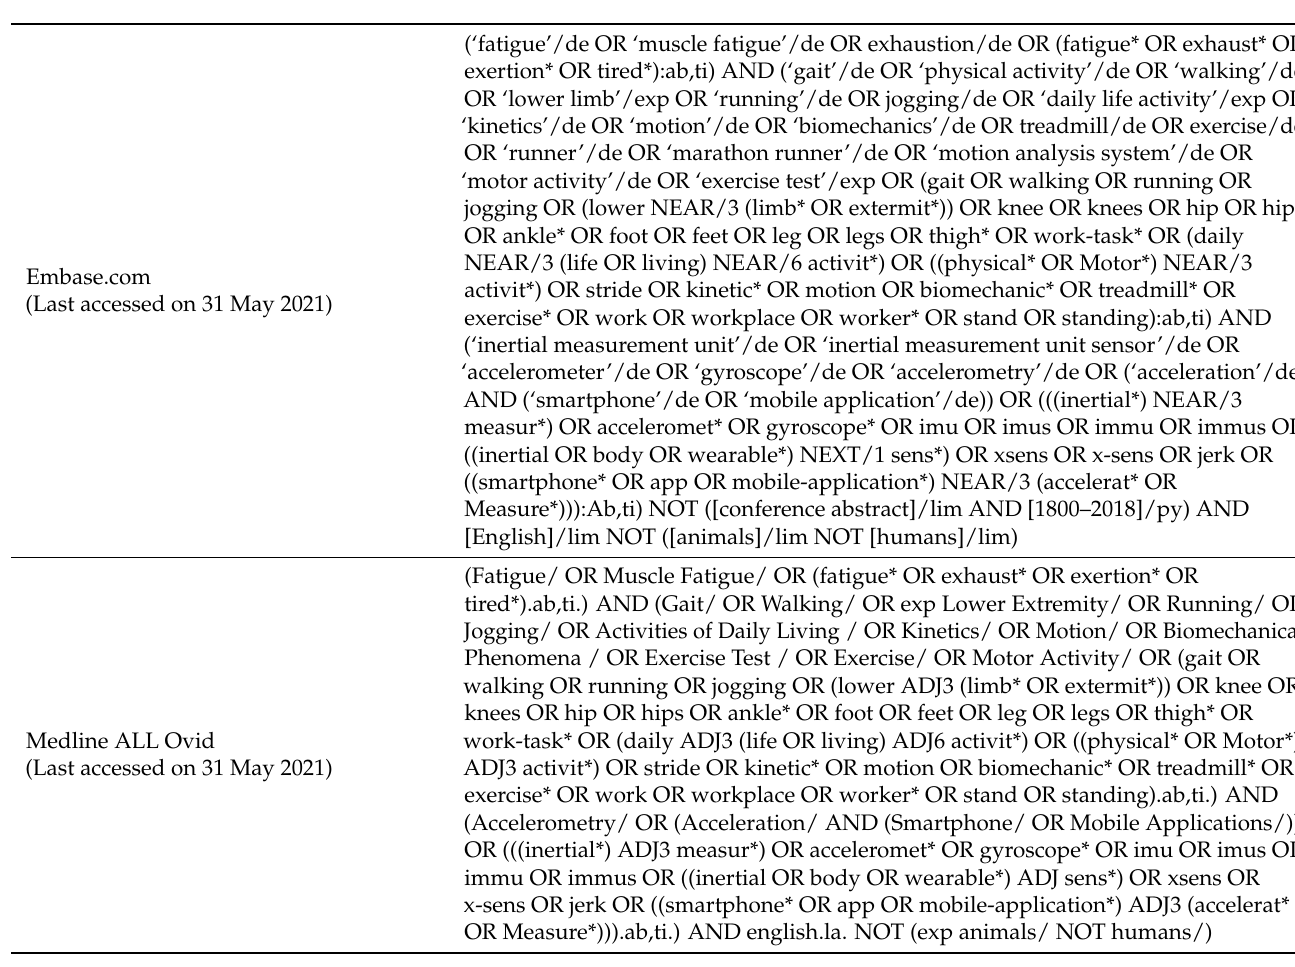
Table A1. Keywords used for each database